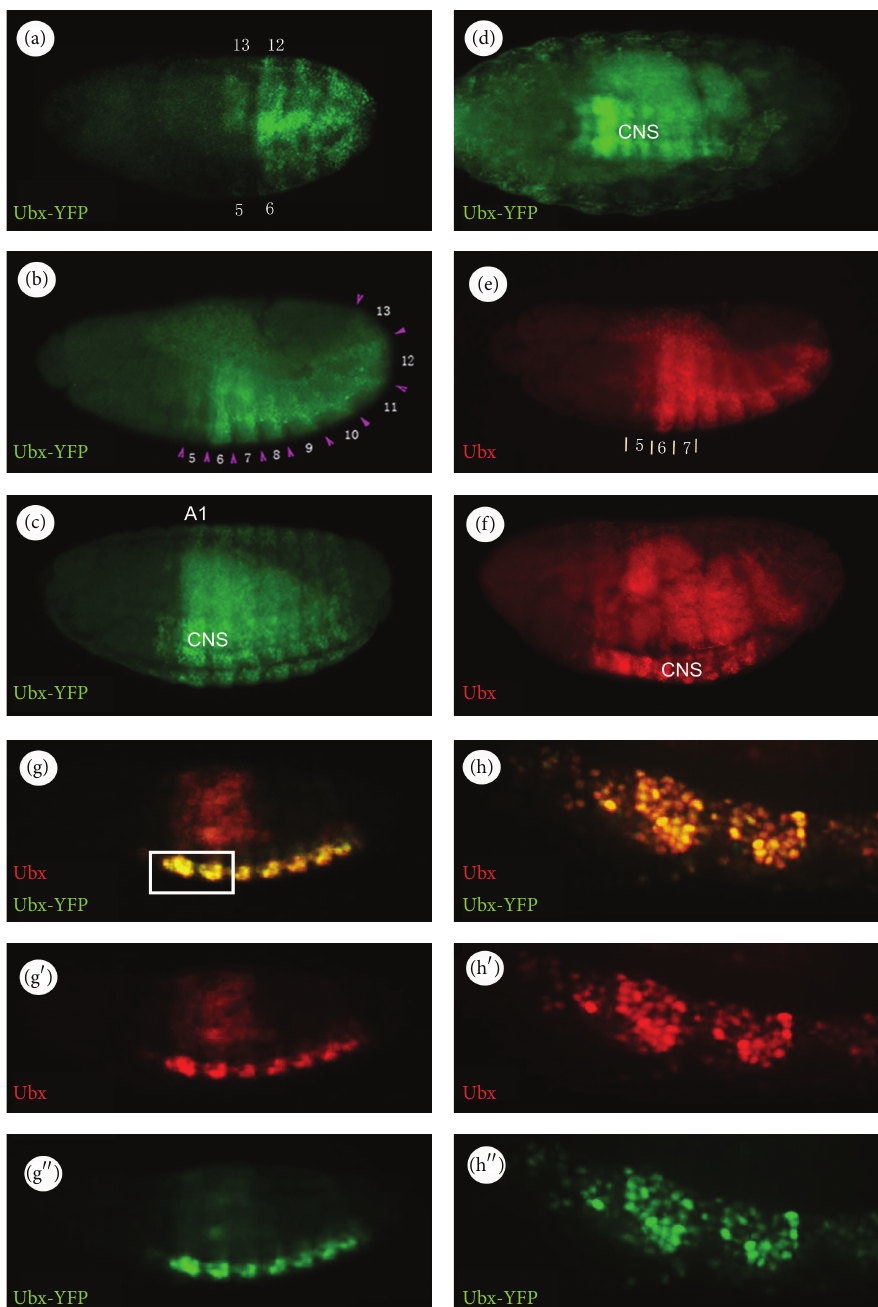
Figure 1: Ubx-YFP expression patterns during embryogenesis. ((a)–(d)) Ubx-YFP labelling; (a) Stage 10 embryo: Ubx-YFP expression is detected in PS5–13. The indicated numbers refer to parasegments; (b) Stage 12 - 13 embryo: Ubx-YFP is expressed in the ectoderm in PS5–13. Ubx-YFPshowsheterogeneouspatternsofexpressionbothwithinandbetweentheparasegments;arrowheadsmarkparasegmentboundaries; (c) Stage 15; (d) Stage 16. ((e)-(f)) Similar expression is observed for the endogenous Ubx gene detected by immunostaining in wild type embryos using 𝛼 -Ubx antibody; (e) Stages 12 - 13 ; (f) Stage 15. ((g)–(g 󸀠󸀠 )) Double-labelling of Ubx-YFP and its endogenous gene using 𝛼 -GFP and 𝛼 -Ubx antibodies, respectively, in Ubx CPTI000601 embryos. ((h)–(h 󸀠󸀠 )) a high magnification of a region boxed in (g). Double-labelling shows that the protein trap has very similar temporal and spatial expression patterns to its endogenous gene. All embryos are viewed laterally with anterior to the